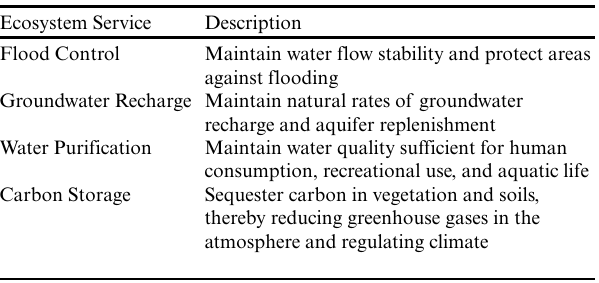
Table 2 . List of ecosystem services included in valuation by Green Infrastructure Vision (GIV) 2.3 (Allen et al.